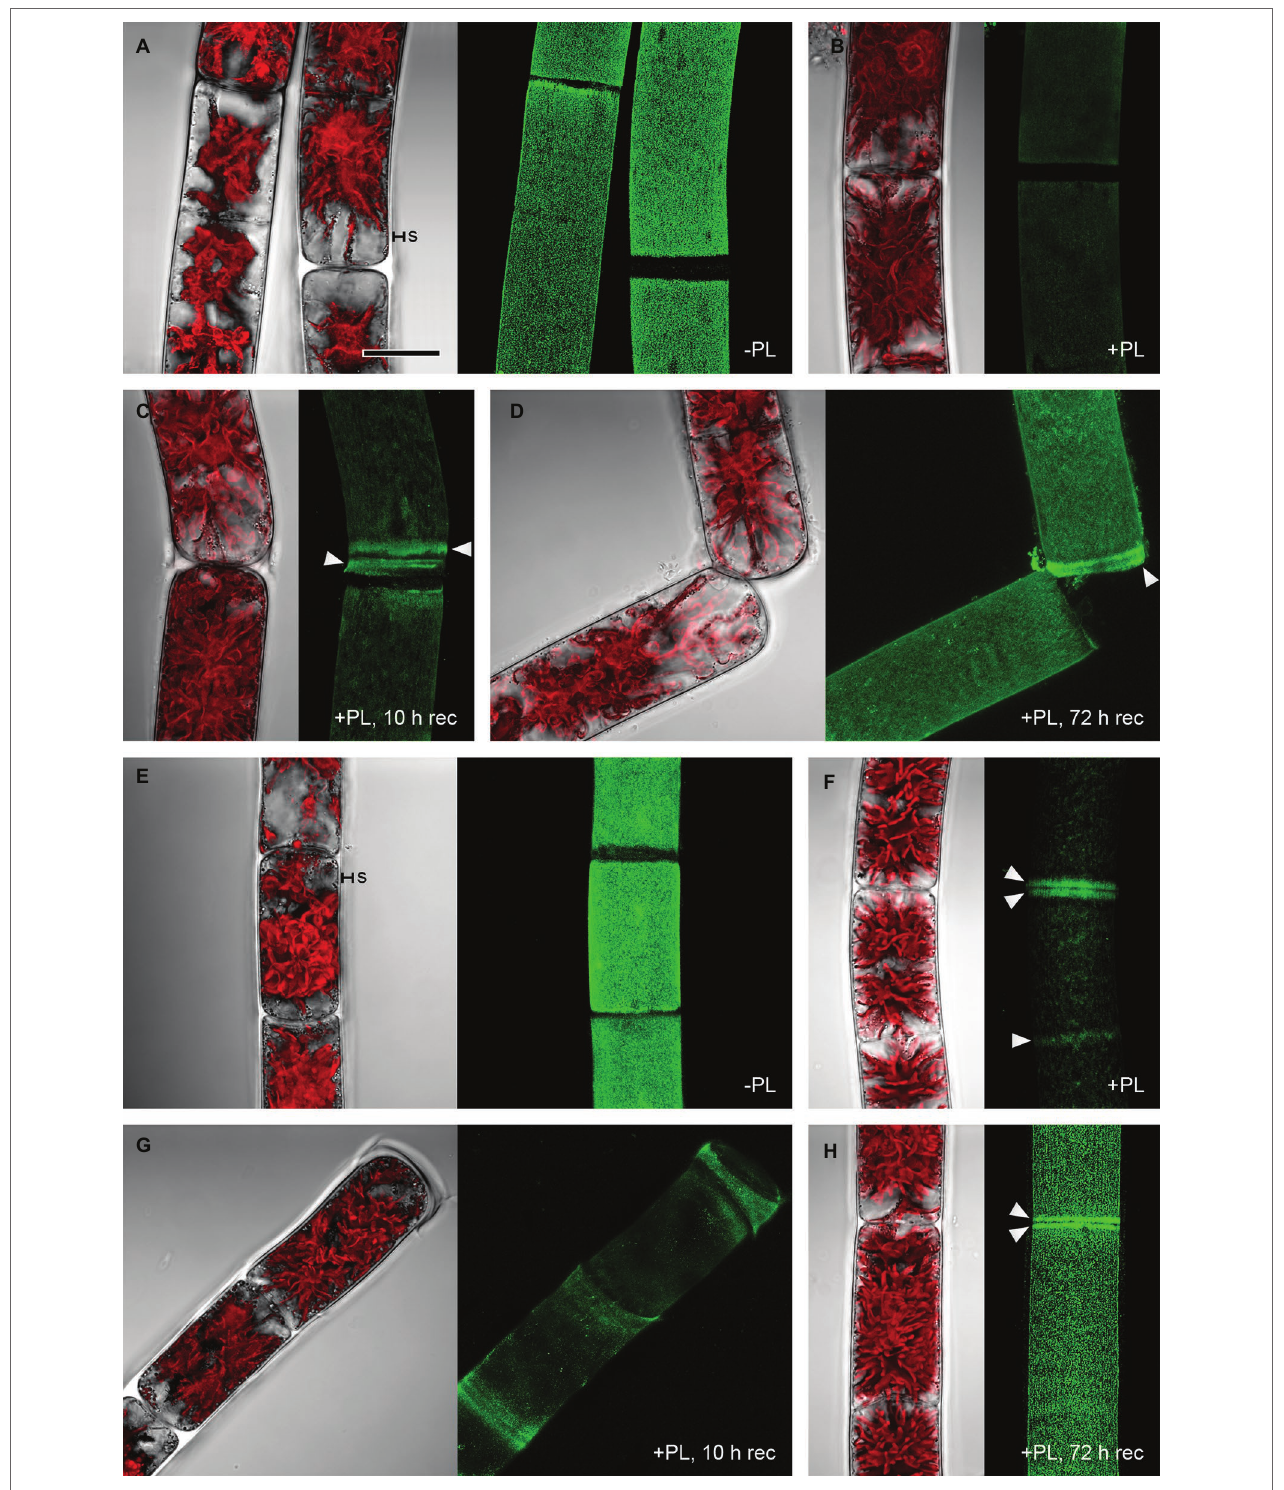
FIGURE 3 | Detection of partially methylesterified homogalacturonan by mAb JIM5 in Zygnema filaments. Young (A–D) and old (E–H) filaments were JIM5-labeled (green, z-stacks) before pectate lyase treatment (−PL), after PL treatment (+PL) or after PL treatment followed by a recovery period (+PL, 10–12 h rec). The corresponding bright-field images include red chloroplast autofluorescence. (A,E) pectic sheath layer (s), (B,F) Labeling strongest close to cross cell walls (arrowheads), (C,G) re-formation of HG matrix next to cross cell walls (arrowheads), (D,H) labeling strongest in cross cell wall areas (arrowheads). Scale bar = 20